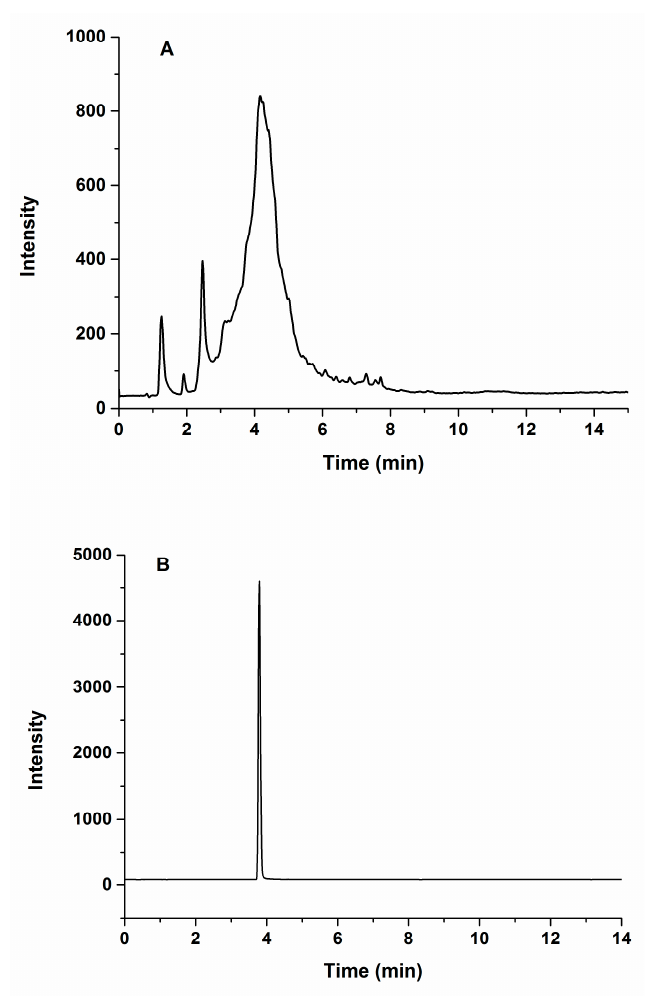
Figure 2. Total ion ( A ) and multiple reaction monitoring (MRM) ( B ) chromatograms of tryptic digestion products from the soybean protein extraction.